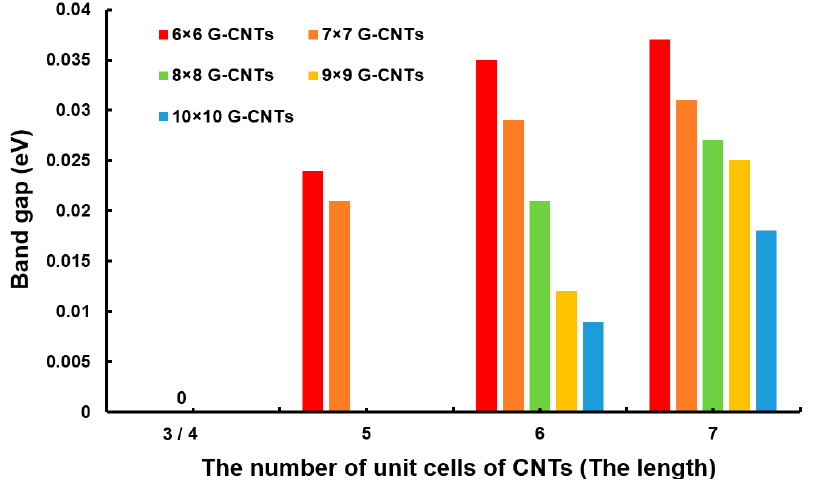
Figure 4. The band gap of different kinds of arm-60. The sizes of the graphene are 6 × 6-, 7 × 7-, 8 × 8-, 9 × 9-, and 10 × 10- unit cells, and the lengths of (6,0) CNTs are 3-, 4-, 5-, 6-, and 7- unit cells, respectively.